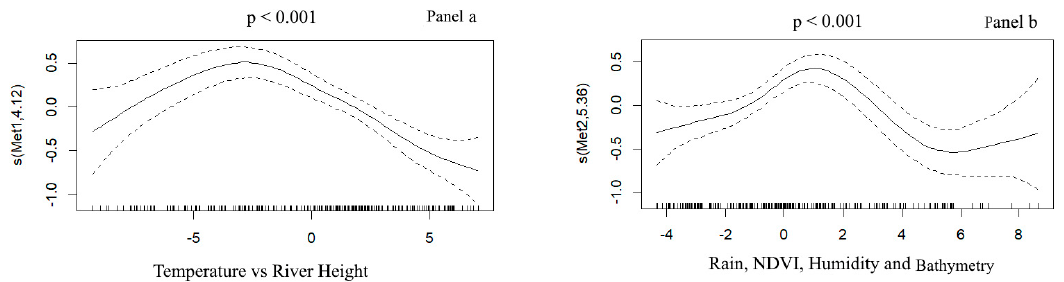
Figure 2. Multivariate generalized additive model (GAM) analysis of synthetic indicators. Panel ( a ) SI 2—temperature vs river height. Panel ( b ) SI 2—rainfall, relative humidity, bathymetry, and